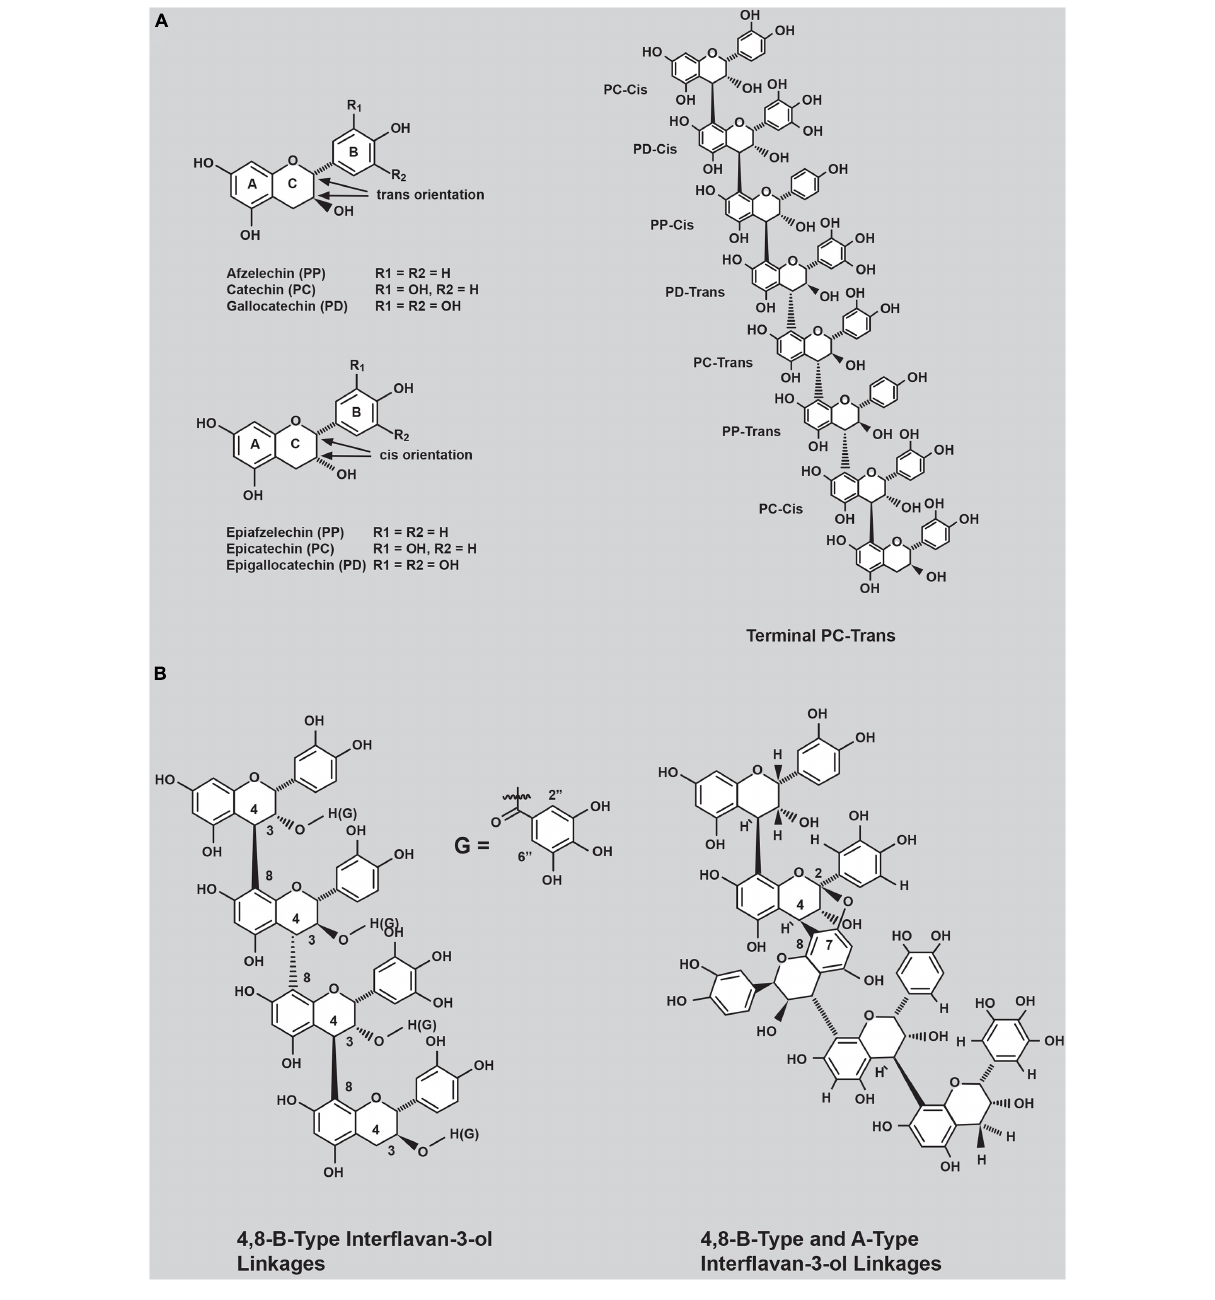
of TaMYB14-1 into a modern large-leafed commercial white clover variety (cv. Mainstay), containing the Tr-RED LEAF “R” locus, is described, followed by the crossing of individual primary transformants into genetically diverse elite cv. Mainstay genotypes toward the development of a robust white clover variety with efficacious levels of CT in leaves. The aim here is to quantify CT concentration and composition in white